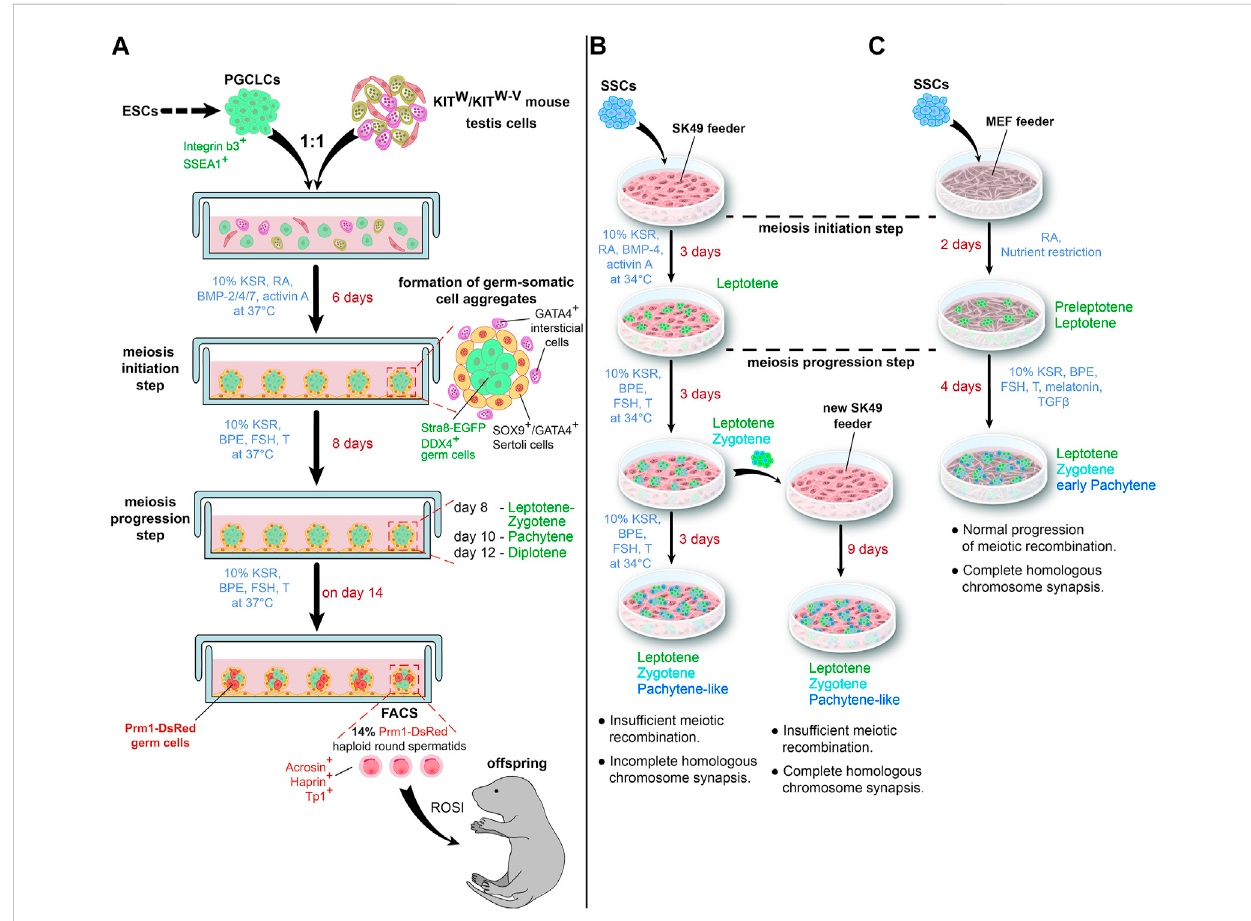
FIGURE 2 Schematic representations of a “ semi-3D ” culture method (A) and an adherent cell culture method (B,C) for in vitro spermatogenesis. (C) illustrates the impact of a nutrient restriction step on in vitro meiosis. T — testosterone.